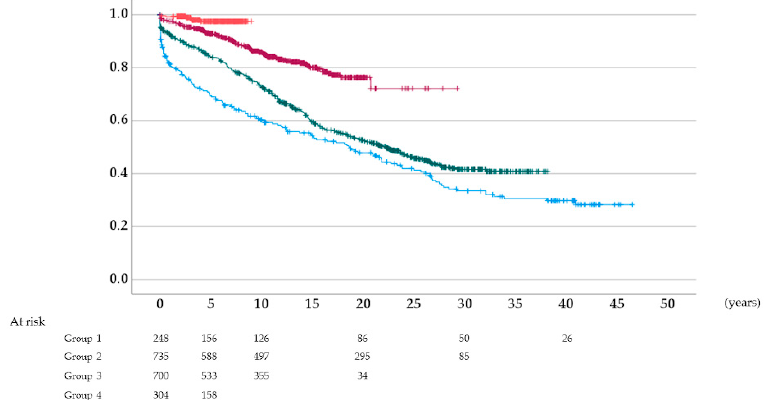
Figure 4. Death-censored graft survival rates after kidney transplantation: Blue, group 1; green, group 2; dark red, group 3; vermilion, group 4.